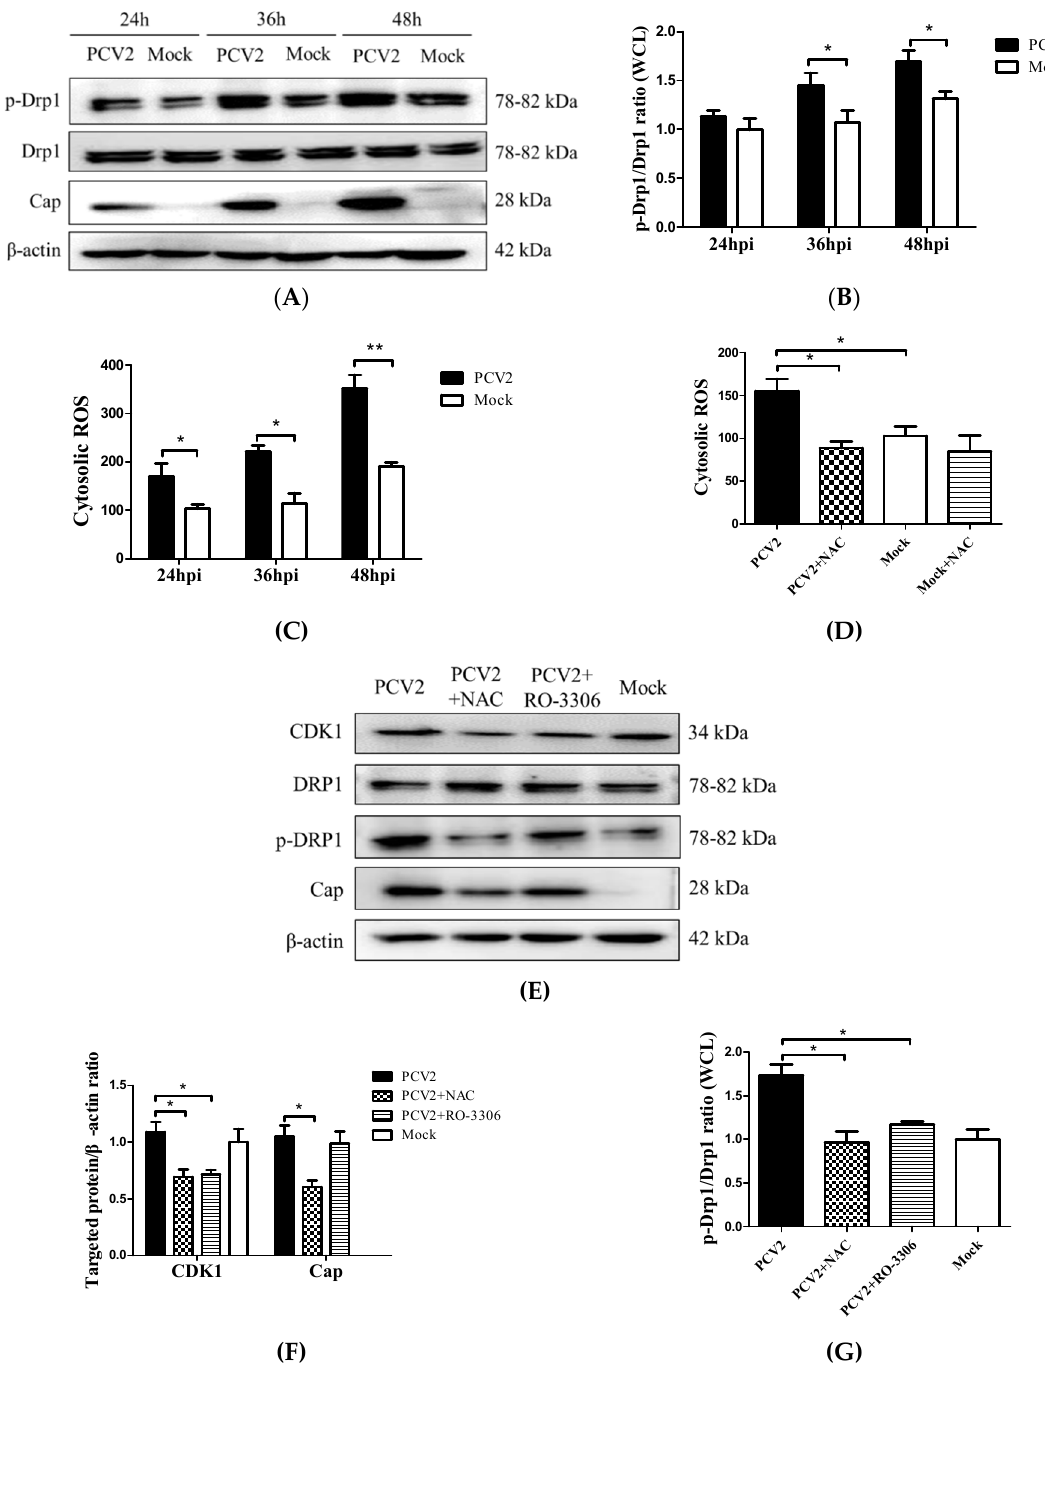
Figure 4. PCV2 infection promoted the Drp1 phosphorylation and reactive oxygen species (ROS) generation, and Drp1 activation could be reversed via treatment with N ‐ acetyl ‐ L ‐ cysteine (NAC) or via the inhibition of CDK1 with RO ‐ 3306. PK ‐ 15 cells were infected with PCV2 (MOI = 1) for 24, 36, or 48 h. Mock ‐ infected cells were used as a control. ( A ) Target proteins of the PK ‐ 15 cell extracts were separated using SDS ‐ PAGE and analyzed using Western blotting with antibodies to p ‐ Drp1 (Ser616), Drp1, and PCV2 ‐ Cap. β‐ actin was used as a protein loading control. The gels shown are representative of three individual experiments. ( B ) The p ‐ Drp1/Drp1 ratio in WCL. ( C ) After 48 hpi, cells were harvested to assess cytosolic ROS using flow cytometry. Cells were treated with 10 μ M DCFH ‐ DA for 30 min at 37 °C in the dark. The cytosolic ROS levels are shown as the mean value of DCF fluorescence intensity. ( D ) The PK ‐ 15 cells were infected with PCV2, treated with 10 mM NAC at 2 hpi, and then incubated for an additional 46 h. The cells were collected for flow cytometry to examine the changes in the cytosolic ROS level. ( E ) The cells were infected with PCV2, treated with 10 mM NAC or 200